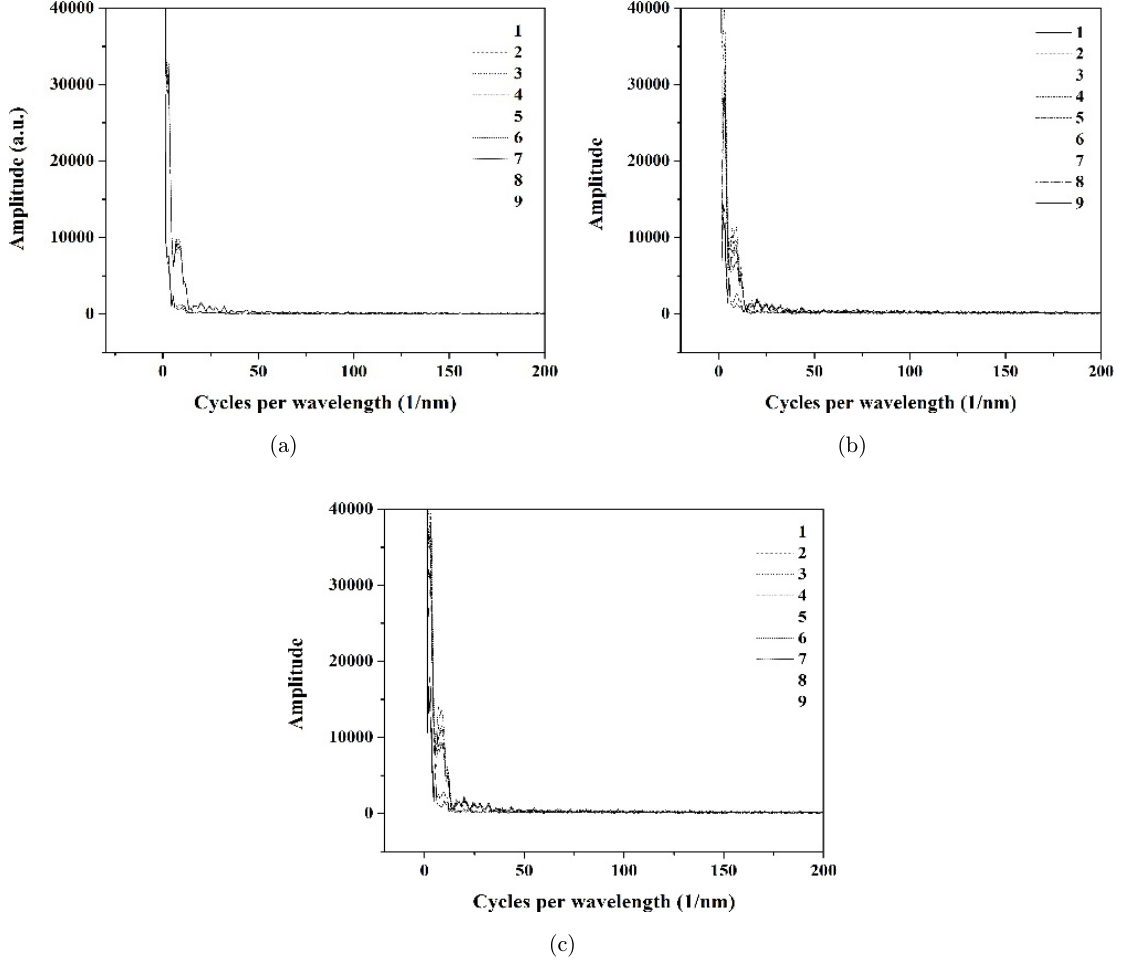
Fig. 3. FFT changes over the whole band in di®erent animal vertebra experiment (a) porcine vertebra, (b) bovine vertebra,